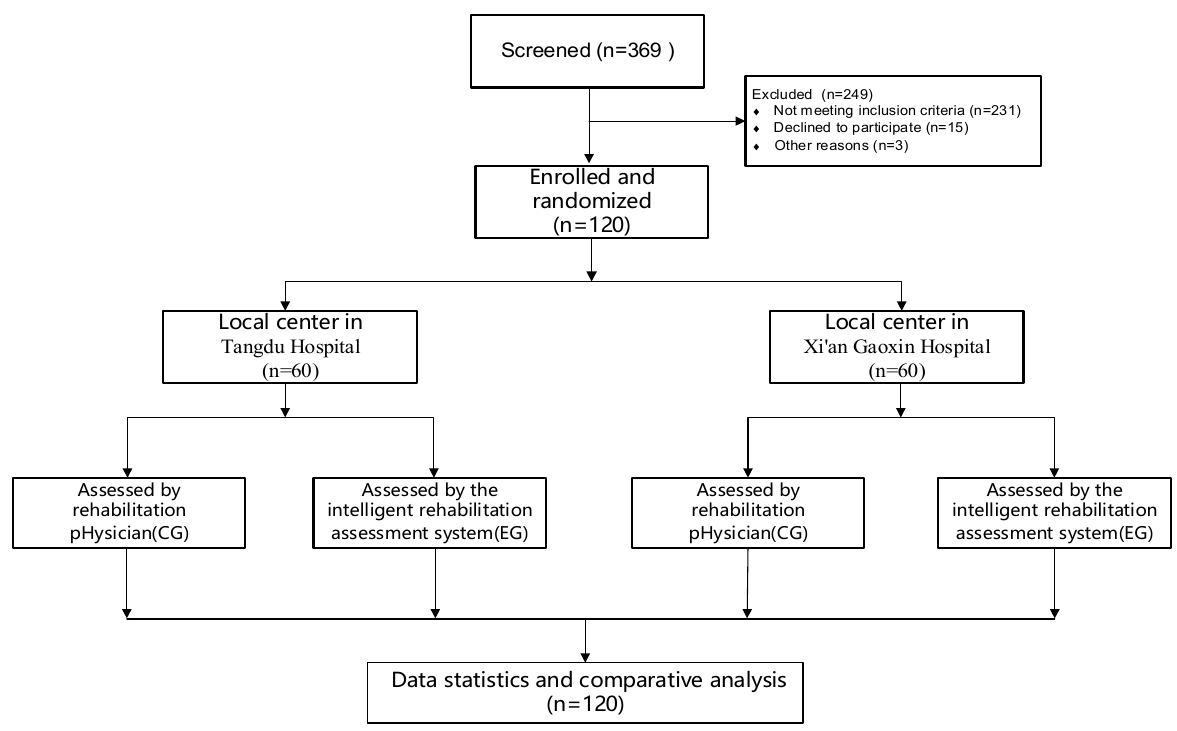
Figure 4. Flow chart of experiment in this study. Table 1. Statistics of baseline characteristics of subjects .